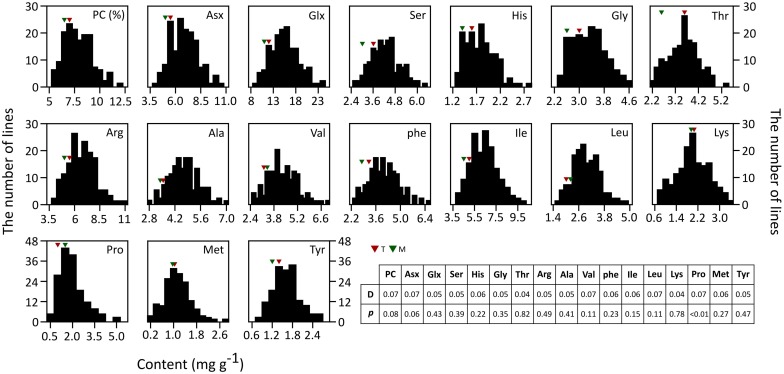
Phenotypic distributions of 16 AACs and PC in brown rice of 155 RILs. Each AAC and PC is represented in percentage and mg/g, respectively. The result of Kolmogorov–Smirnov test used to test normality of distribution is shown in table (p ≤ 0.05).